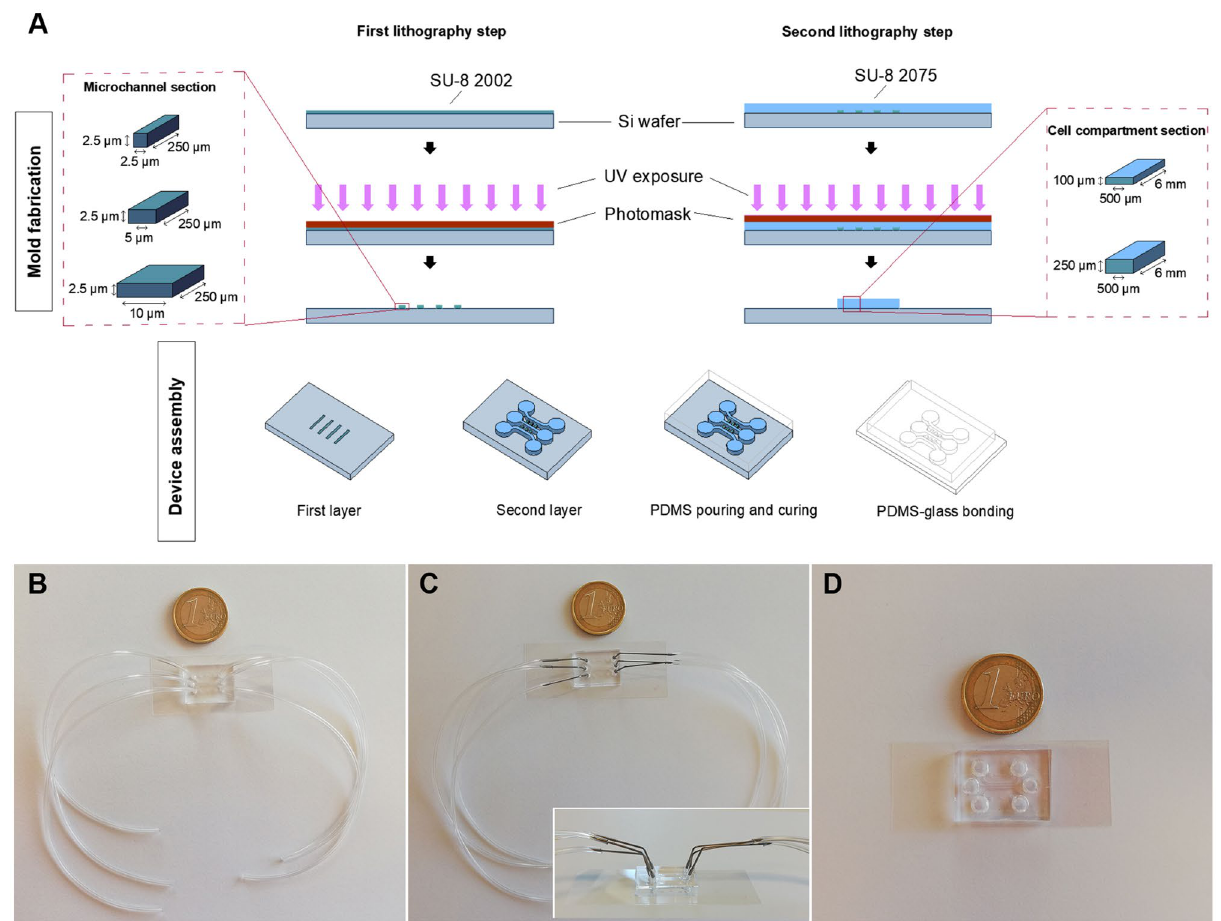
Figure 1. ( A ) Fabrication of the microfluidic device. The mold was realized on a silicon wafer via two-step photolithography process (top side). The final PDMS device was fabricated using soft lithography techniques: PDMS mix was poured on the mold, cured, and peeled off. The replica was sealed on a coverslip by means of oxygen plasma treatment and temperature (bottom side). ( B – D ) Chip setups for cell culture. ( B ) Tube system (TS). ( C ) Steel connectors system (SCS). ( D ) Reservoirs system Since SH-SY5Y are neuroblast-like cells, they can be differentiated into a more mature neuronal phenotype using several differentiating agents, including retinoic acid (RA) and neurotrophins (i.e. Brain-derived neuro- trophic factor, BDNF) 30,31 . The differentiation method used in this work was developed by Forster et al 32 . The differentiation of SH-SY5Y cells can be divided into two steps using phase 1 and phase 2 media. According to this approach, after 7 days the cells will be differentiated. In particular, the phase 1 medium is composed of DMEM (without sodium pyruvate), 5% FBS, 1% P/S, 1% l-glutamine supplemented with 10 µM RA (Santa-Cruz Biotech- nology, Dallas, TX, US) included just before the medium is added to the cells. The phase 2 medium is composed of Neurobasal-A minus without phenol red (Invitrogen, Carlsbad, San Diego, US), 1% P/S, 1% l-glutamine, 1 × B27 (Gibco), supplemented with BDNF (Biolegend, San Diego, California, US) at a concentration of 50 ng/ mL. In our experiment, the cells were pre-differentiated with phase 1 medium in Petri dish and then, detached and seeded in the central compartment of the microfluidic device at a cellular concentration of 1 × 10 6 cells/mL. The cells were maintained in culture on chip for 7 days, under dynamic conditions, using the phase 2 medium . The medium was pumped by means of an external programmable syringe pump (NE-4000, New Era Pump Systems, Farmingdale, NY, US) with a flow rate of 0.1 µL/min. Primary rat Schwann cells. All animal procedures were approved by the Internal Ethical Committee of Uni- versity of Salento, authorized by the Italian Ministry of Health (authorization n° 109/2014-B) and performed according to the current Italian and EU animal welfare legislation and in compliance with ARRIVE guidelines. Pregnant Sprague–Dawley rats were purchased from Harlan Srl and were housed under a 12/12-h light–dark cycle in standard environmental conditions (22 ± 1 °C, 50 ± 5% humidity) with food and water at libitum. The day of birth was counted as postnatal day 0 (P0). Primary Schwann cells were purified from sciatic nerves of male and female newborn rats at P3 (3 days old) as described previously 33 . Briefly, upon isolating from the sur- rounding muscle and connective tissue, nerves were digested in 0.1% collagenase and 0.25% trypsin at 37 °C